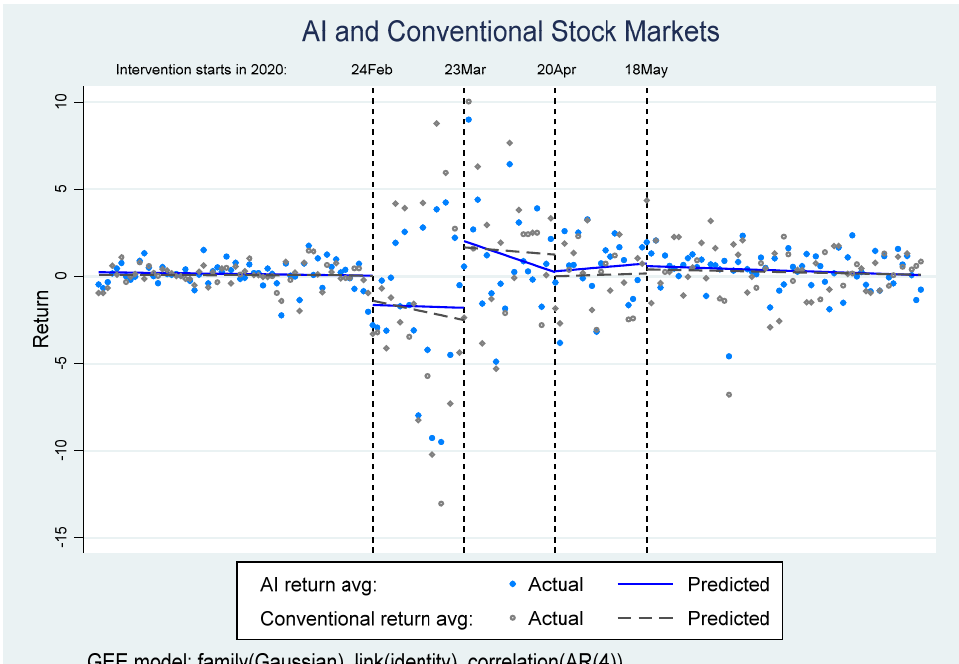
Figure 5. Multiple impacts of COVID-19 on artificial intelligence and conventional stock markets. Source: Authors’ illustration. Note: The multiple impacts of the COVID-19 interventions t 1 (24 Feb-